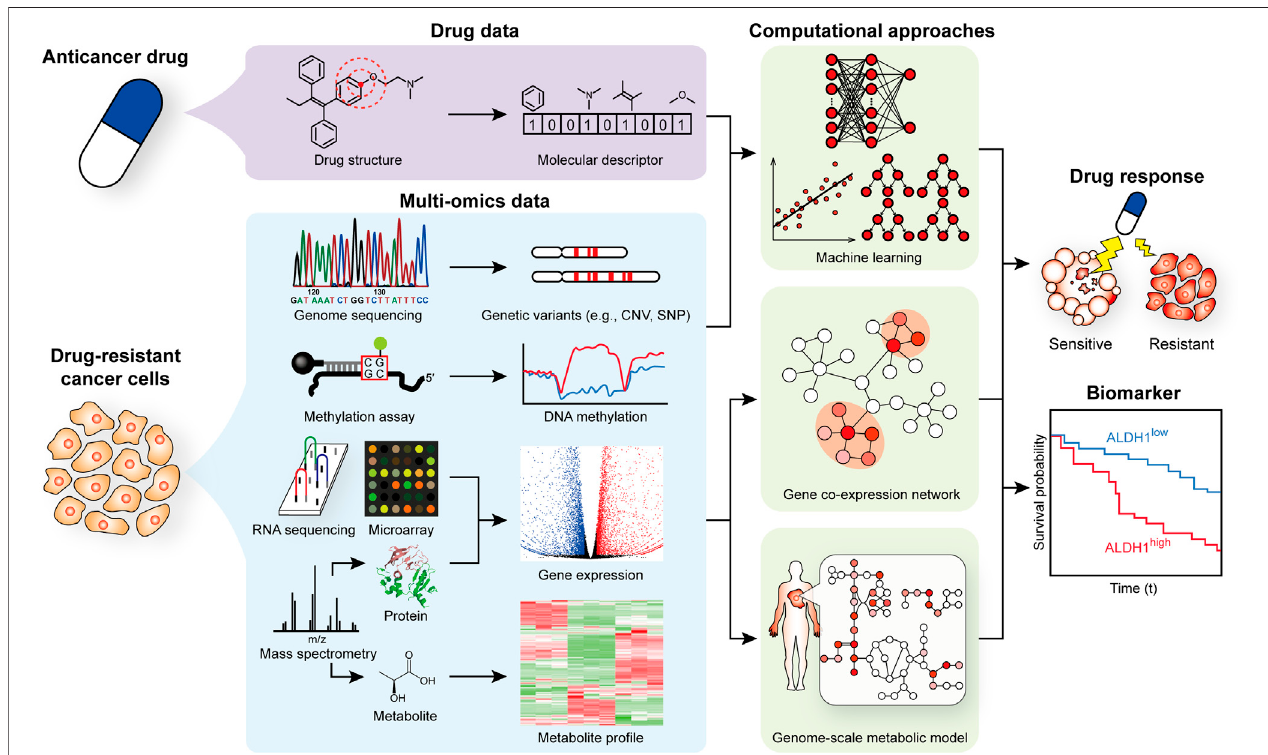
FIGURE 1 | Scheme of omics data generation and computational modeling to better understand and treat drug-resistant cancer cells.